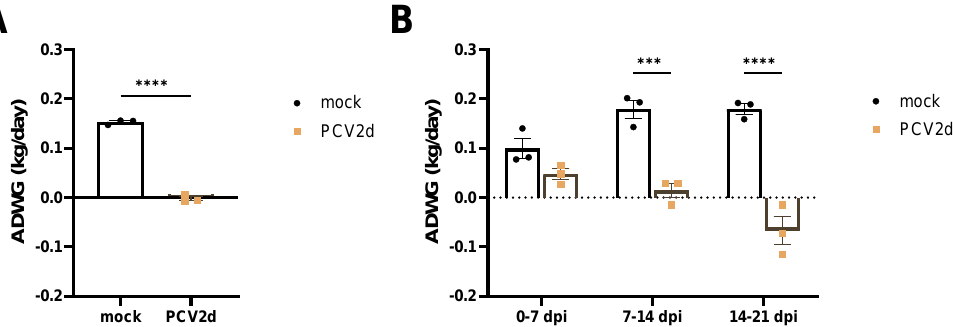
Figure 2. Growth performance of mock and PCV2d infection groups in the experimental infection/pathogenicity study (Experiment 1). The average daily weight gain (ADWG) was calculated during experimental periods: overall PCV2d infection (0–21 dpi, 21 days) ( A ), and each week after PCV2d infection (0–7 dpi, 7–14 dpi, and 14–21 dpi) ( B ). All data are presented as group means ± SEM. Statistically significant differences are indicated at p < 0.001 (***), and p < 0.0001 (****). 3.2. Experiment 1: PCV2d Viremia, Viral Shedding, and PCV2-Specific IgG PCV2d was not detected in the samples of serum or nasal or fecal swabs obtained from the mock group throughout the inoculation period. However, in the PCV2d infection group, a gradual increase in PCV2 genome copies was detected in all samples (Figure 3A). Increases in PCV2-specific IgG levels were not detected in any pigs in the PCV2d infection group or the mock group (Figure 3B).